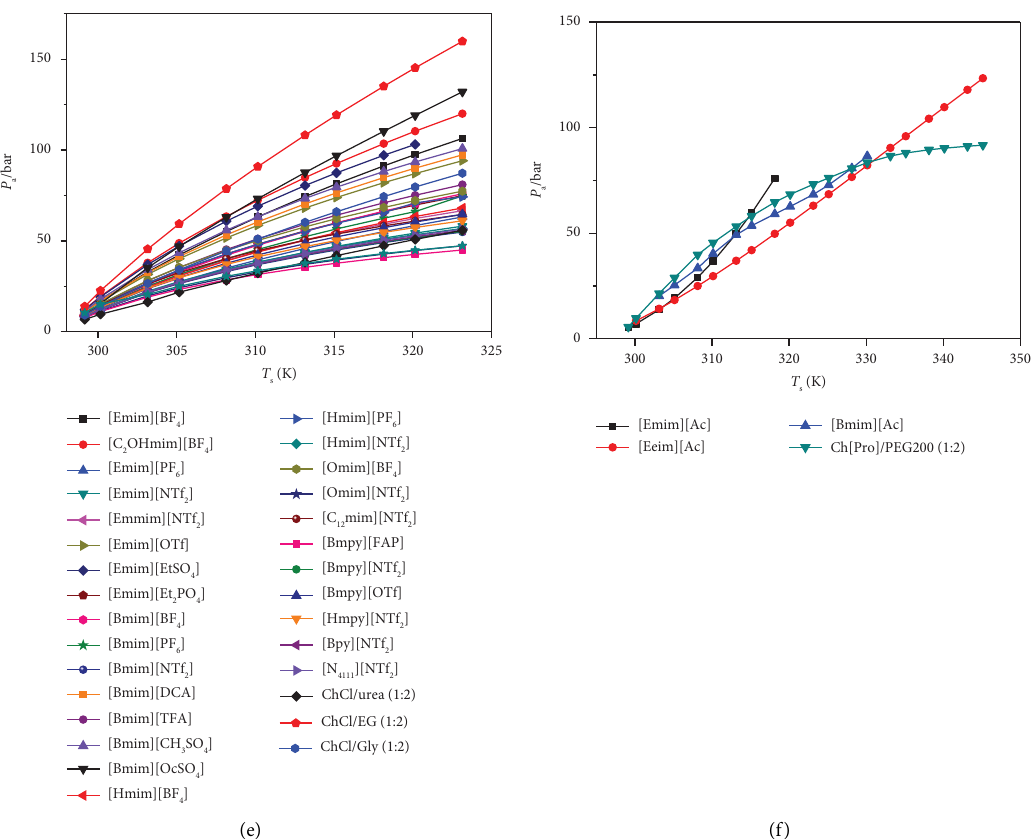
Figure 3: Te absorption pressures of (a) 30 physical absorbents for efuent gases, (b) 4 chemical absorbents for efuent gases, (c) 30 physical absorbents for kiln gas, (d) 4 chemical absorbents for kiln gas, (e) 30 physical absorbents for biomass syngas, and (f) 4 chemical absorbents for biomass syngas.